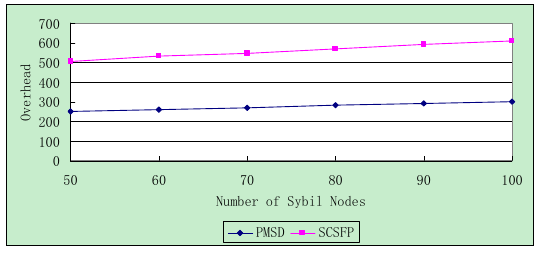
Fig.5. Total overhead